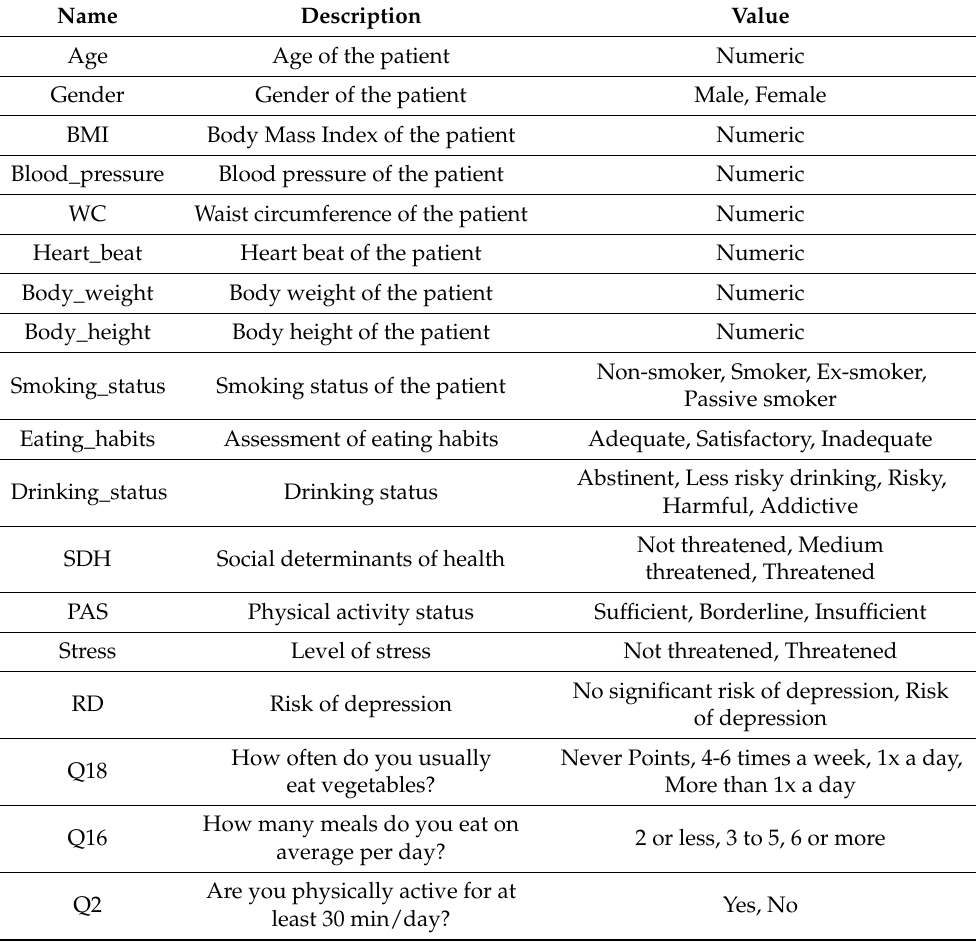
Table A1. List of original features with description and their possible values. Please note that Nominal features were processed in such a way that for each possible value a new feature was generated. For example, the feature Q43 resulted in three features for each possible value (new features were named Q431, Q432 and Q433). Drug features are marked with the Anatomical Therapeutic Chemical (ATC) classification. The final set contained 170